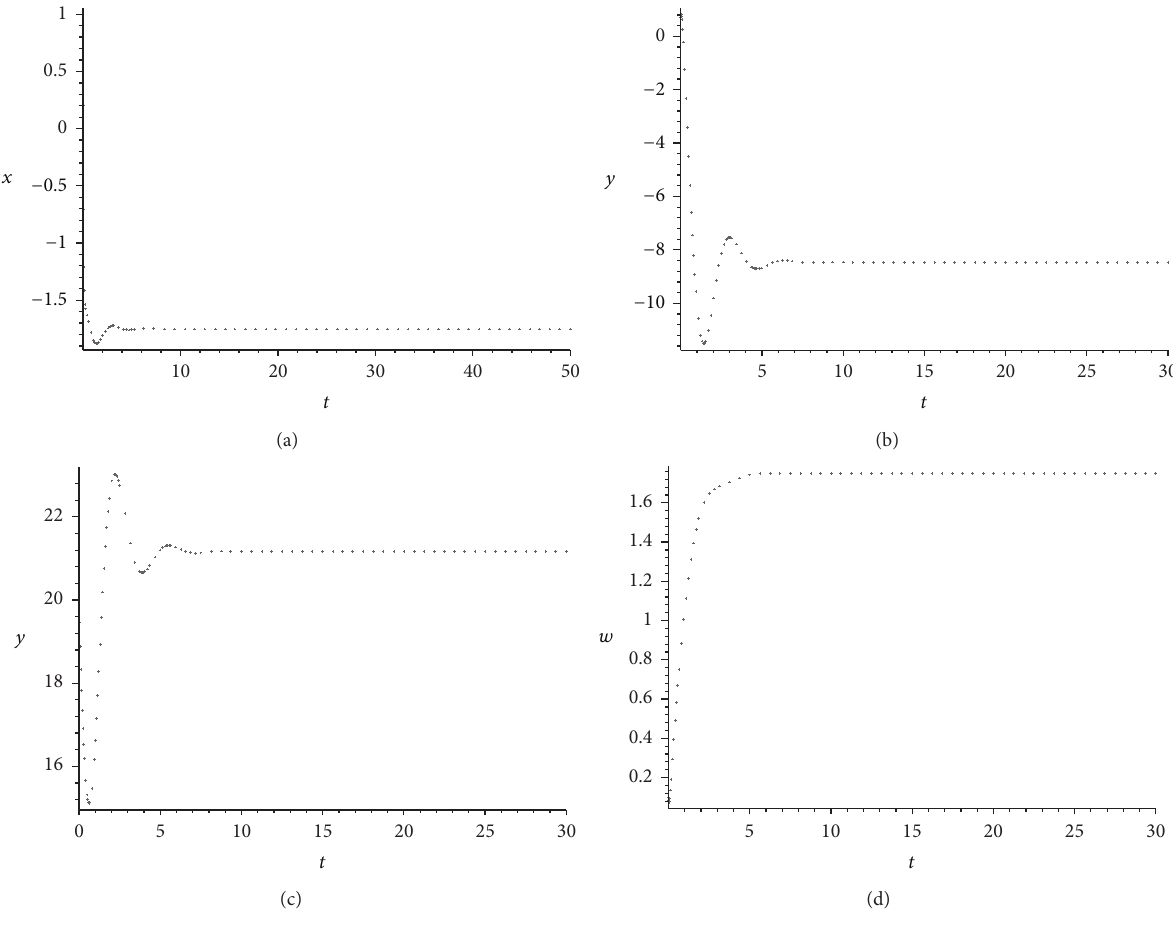
Figure 5: The states of system (25): (a) 𝑥 - 𝑡 , (b) 𝑦 - 𝑡 , (c) 𝑧 - 𝑡 , and (d) 𝑤 - 𝑡